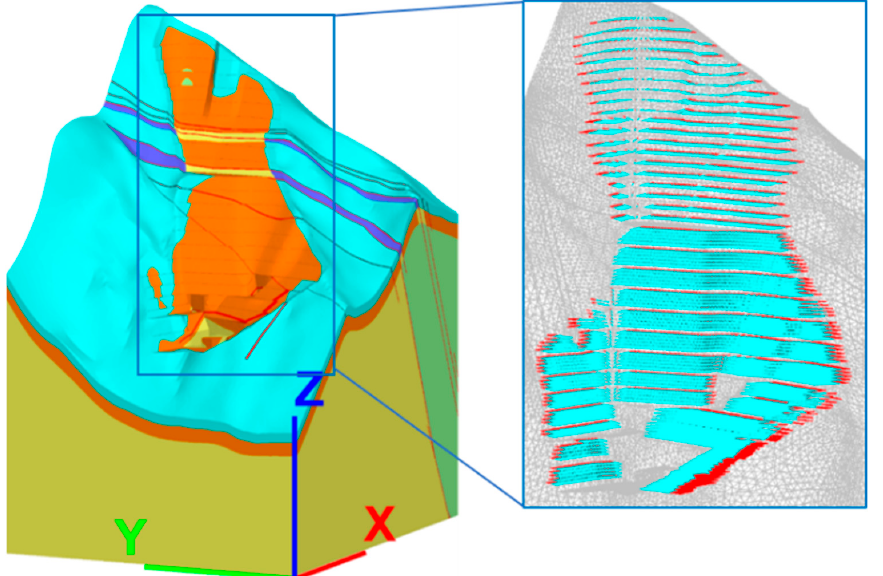
Figure 5. Numerical model and control support arrangement.